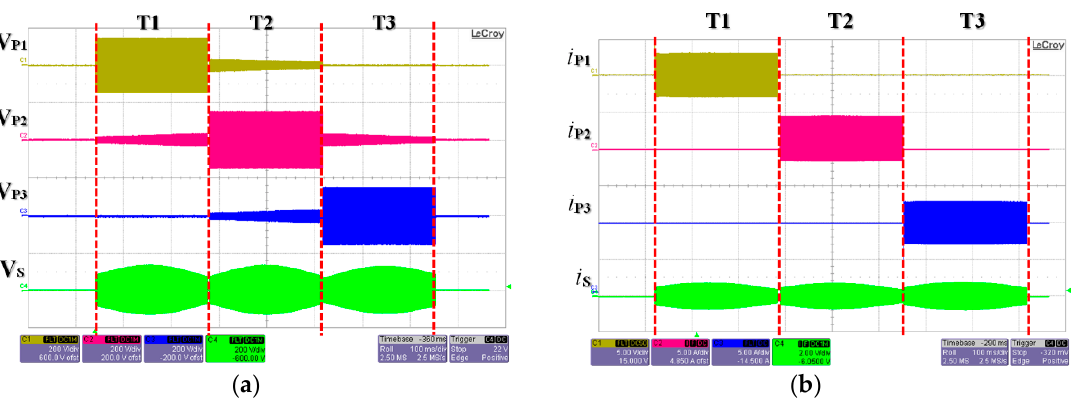
Figure 9. Waveforms of the P topology IPT system operated at mode 1H (air gap: 10 mm; time: 100 ms/div.; voltage: 200 v/div.; current i p1 , i p2 , and i p3 : 5 A/div.; current i s : 2 A/div.). ( a ) Voltages; ( b ) Currents.